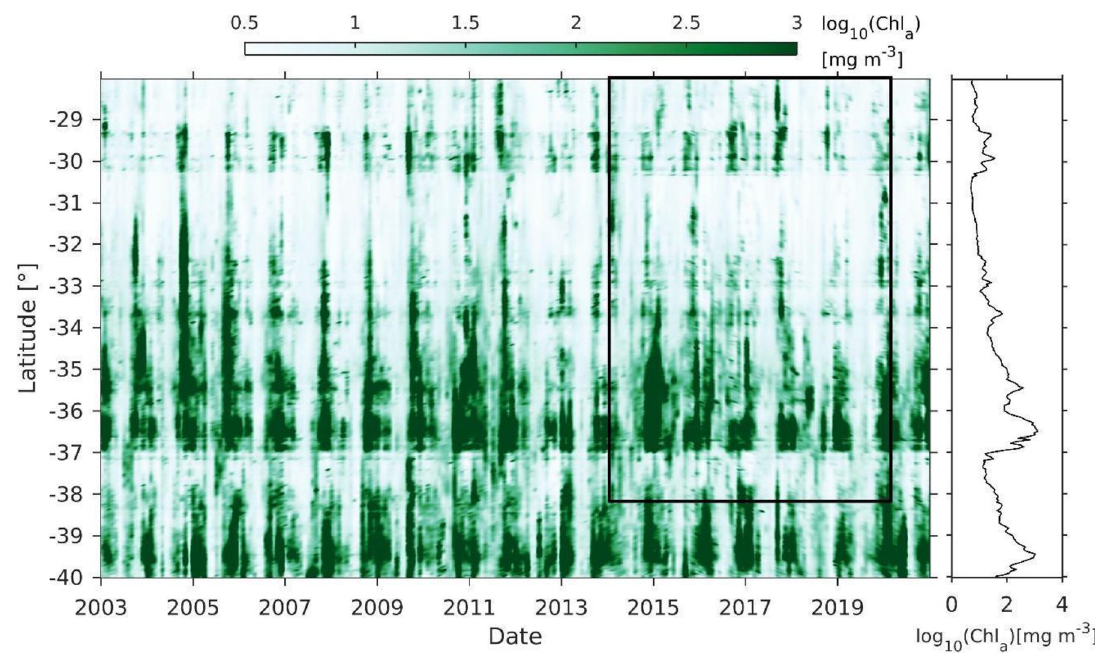
Fig 9. Hovmo¨ller diagram of monthly coastal (first 100 nm) log-transformed Chlorophyll- a (Chl-a) between 28˚S and 40˚S. The black box indicates the spatio-temporal scale of the discard data of the crustacean demersal fishery. The right panel shows latitudinal variation in the mean value throughout the